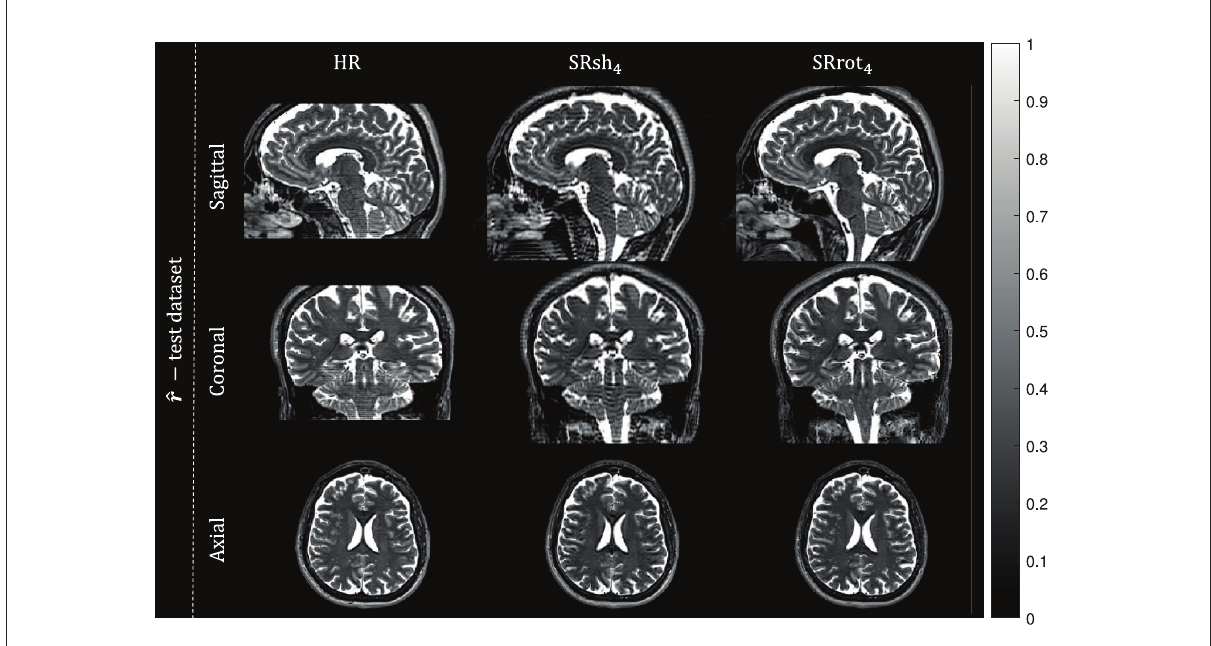
FIGURE6 Real data results: MS-SRR images. The views from orthogonal planes of the MS-SRR images estimated from the test dataset for each protocol are shown.